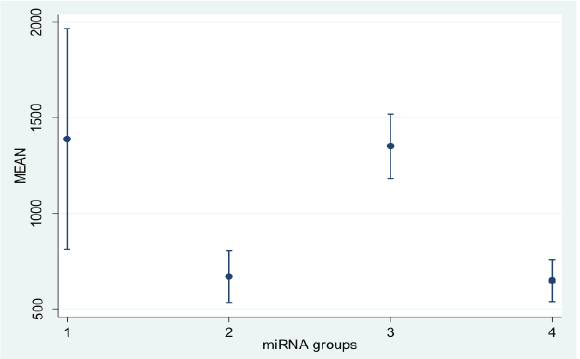
Supplementary Figure 3: 95% Confidence Interval Plot for miRNA-122 Supplementary Figure 4: 95% Confidence Interval Plot for